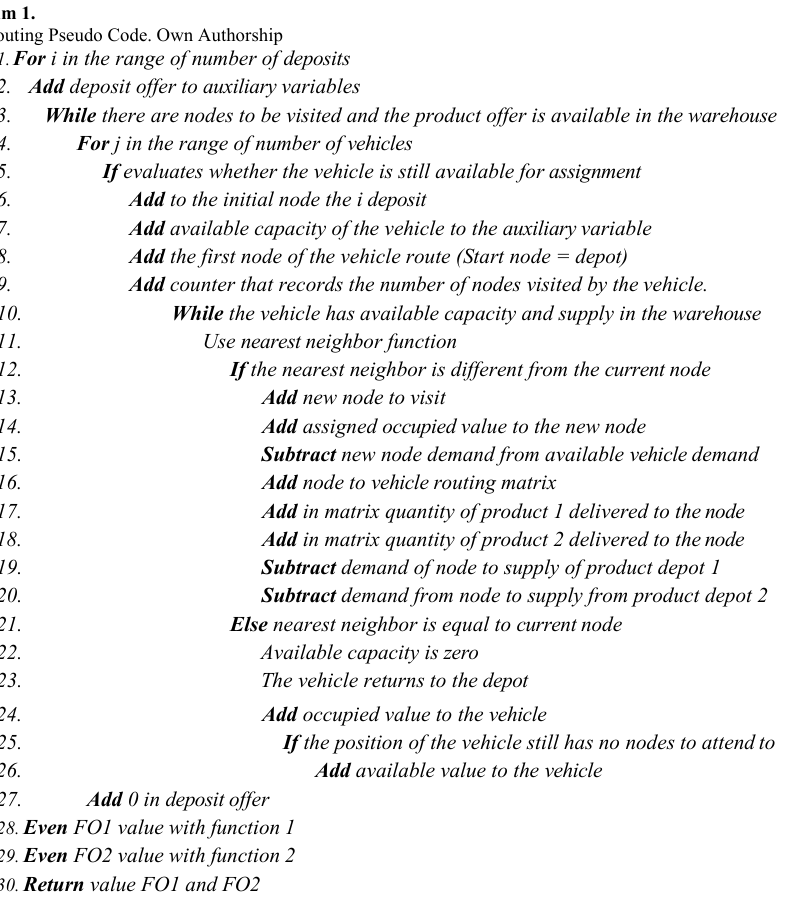
Algorithm 1. Initial Routing Pseudo Code. Own